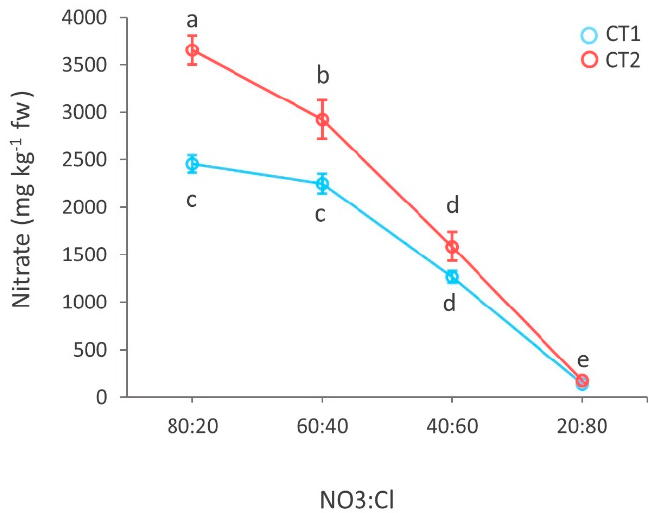
Figure 3. Main effect of the NO 3 − :Cl − ratios in the nutrient solution in the two harvest on nitrate content of basil (CT1: azure; CT2: salmon). Different letters indicate significant differences according to Duncan’s test ( p = 0.05). All data are expressed as mean standard error, n = 3.